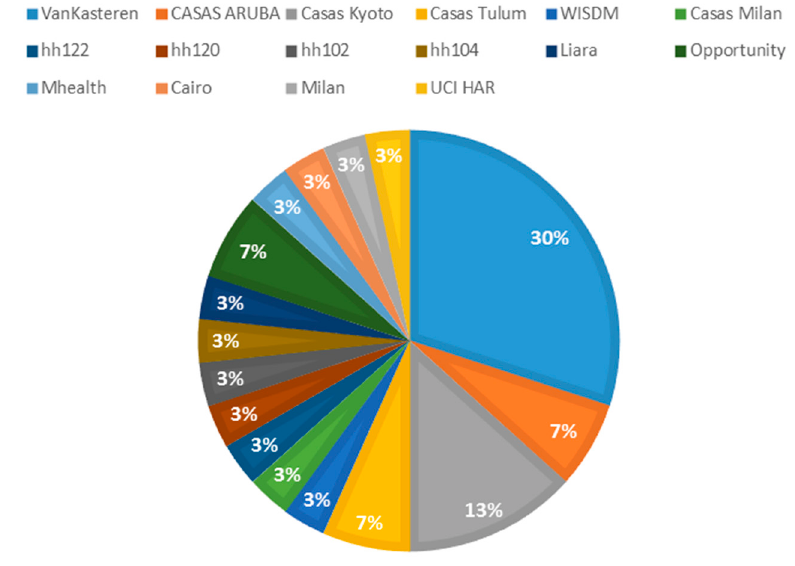
Figure 13. Search features of the review.